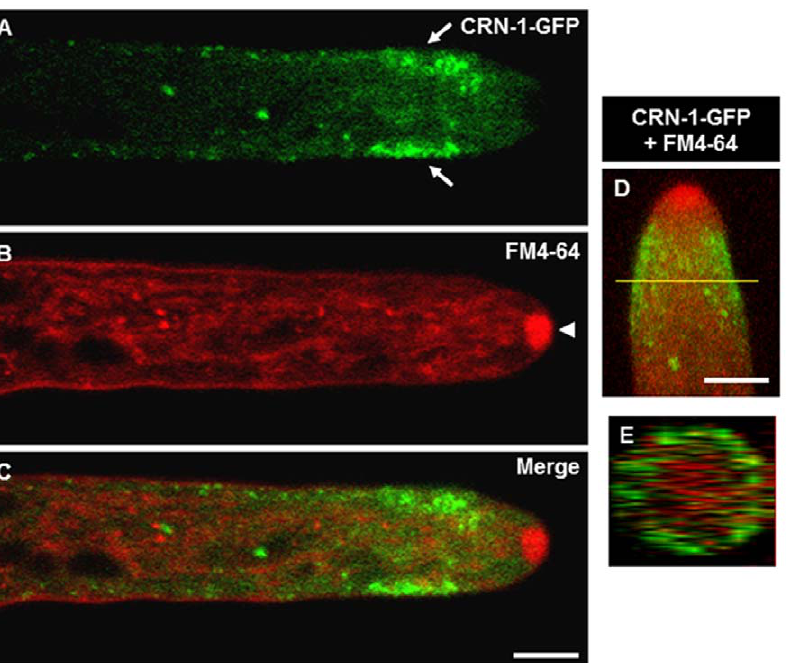
Figure 1. Subapical localization of coronin. (A) CRN-1-GFP forms a subapical collar along the inner perimeter of the hypha (arrows), (B) FM4-64 staining reveals the position of the Spk (arrowheads), (C) merge of CRN-1-GFP and FM4-64 staining shows the absence of CRN-1-GFP in the Spk, single confocal plane images. (D) 3D reconstruction of merged confocal z-stacks showing CRN-1-GFP and FM4-64 localization, (E) orthogonal view of the 3D reconstruction shown in (D), the yellow line indicates the position within the tip where the cross-section was taken. Scale bars=5 m m.